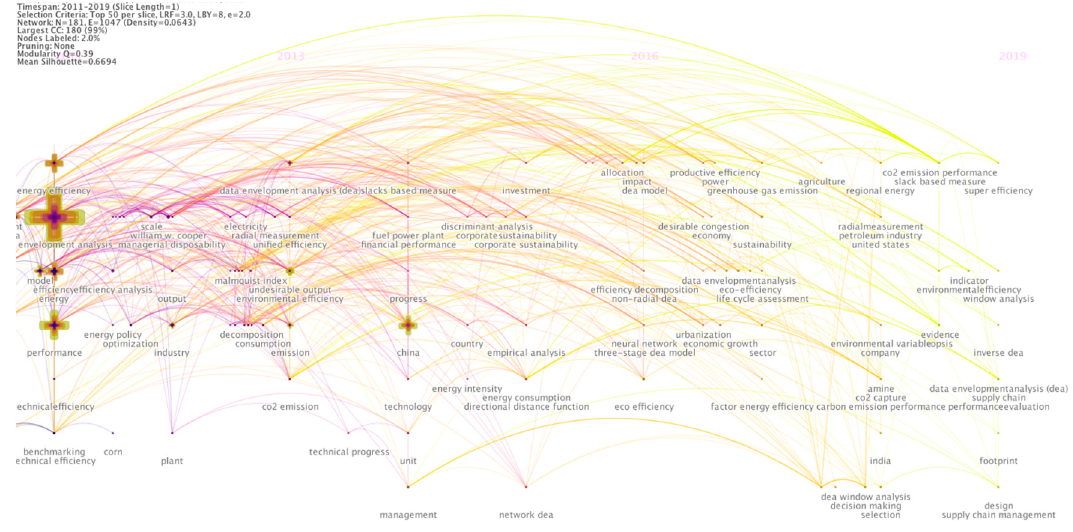
Figure 3. The context of keyword evolution.